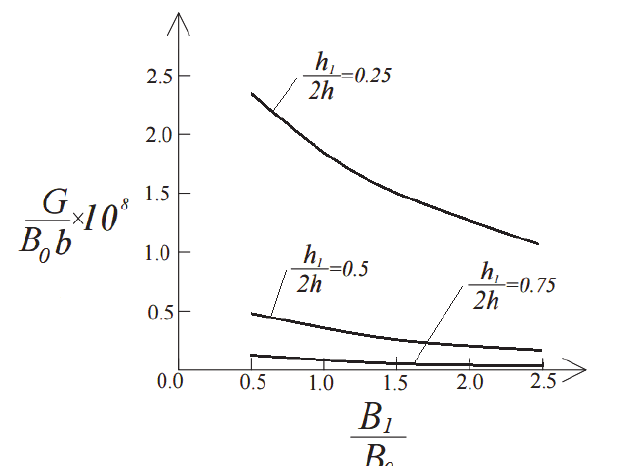
Figure 6: The strain energy release rate in non-dimensional form plotted against 1 0 / B B ratio at three 1 / 2 h h